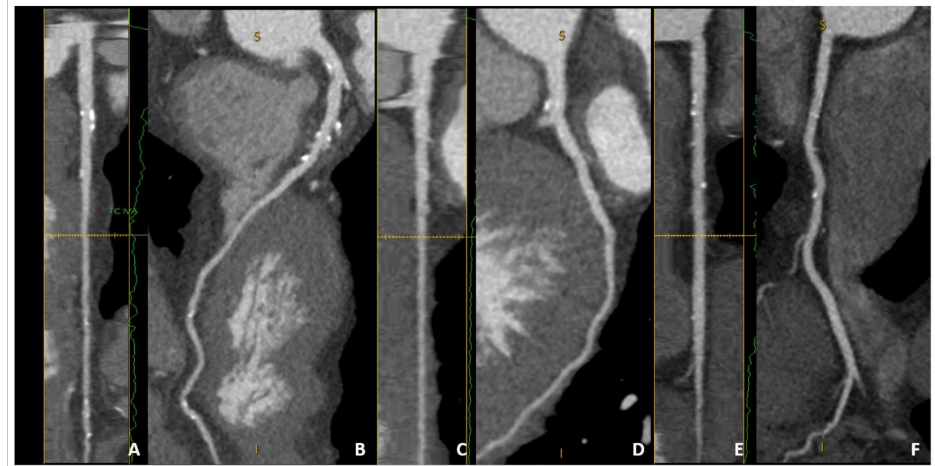
Figure 3. A case example of an asymptomatic 70-year-old female with multiple risk factors. Moderate CACS values (between 100 and 400) can be associated with diffuse but nonsignificant calcified plaque. Of note, no high-risk features or severe stenosis were identified on LAD (panels ( A , B )), LCX (panels ( C , D ), or RCA (panels ( E , F )). Of interest, both CACS and CCTA identify a low-to-moderate risk of future cardiovascular events despite multiple cardiovascular risk